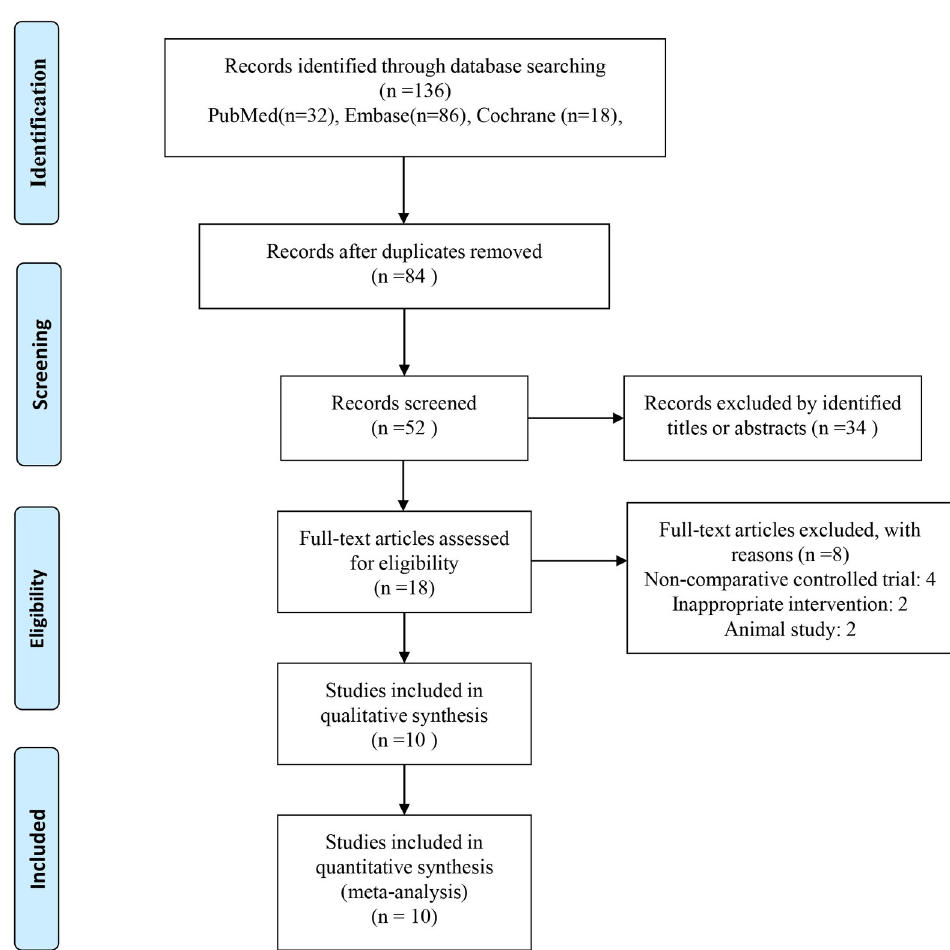
Fig 1. Flow diagram of the relevant study selection